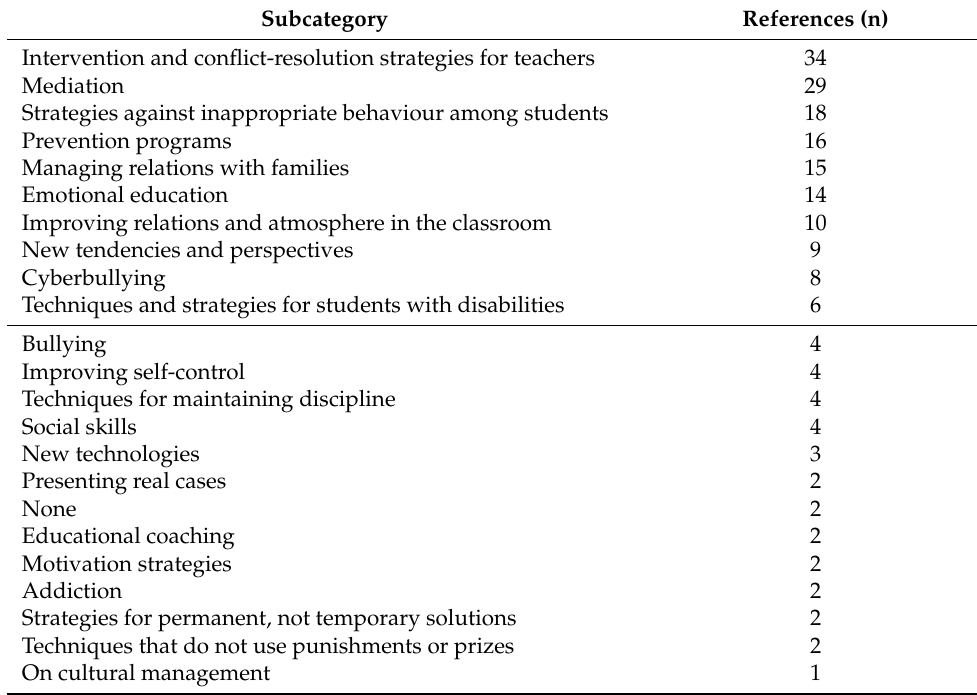
Table 8. Analysis of category 3. Areas in which to train for conflict